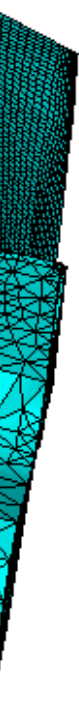
Figure 1. Finite element model of the basic sector.